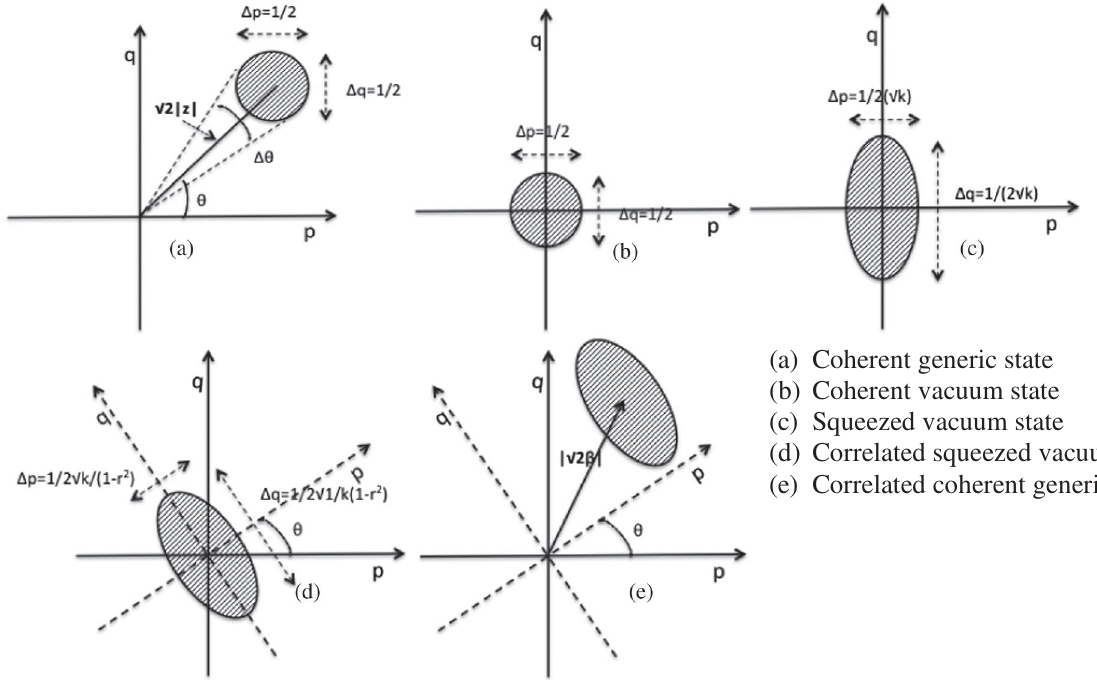
FIG. 1. Uncertainty areas in phase space: a) coherent generic state, b) coherent vacuum state, c) squeezed vacuum state, d) correlated squeezed vacuum state, e) correlated coherent generic